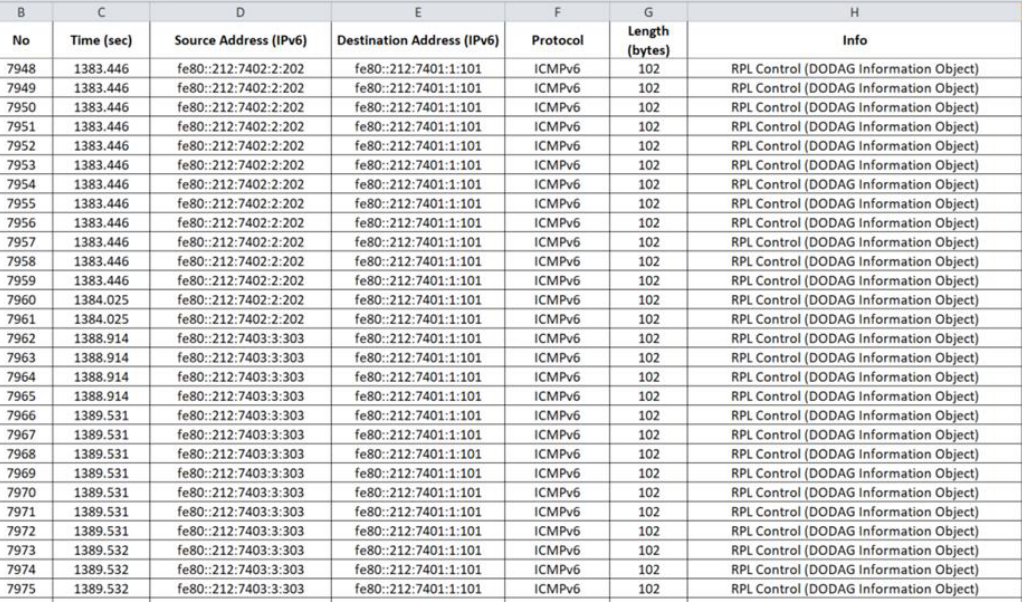
Figure 22. Benign “radiologICMPv6.csv”— 7948 to 7975 records.